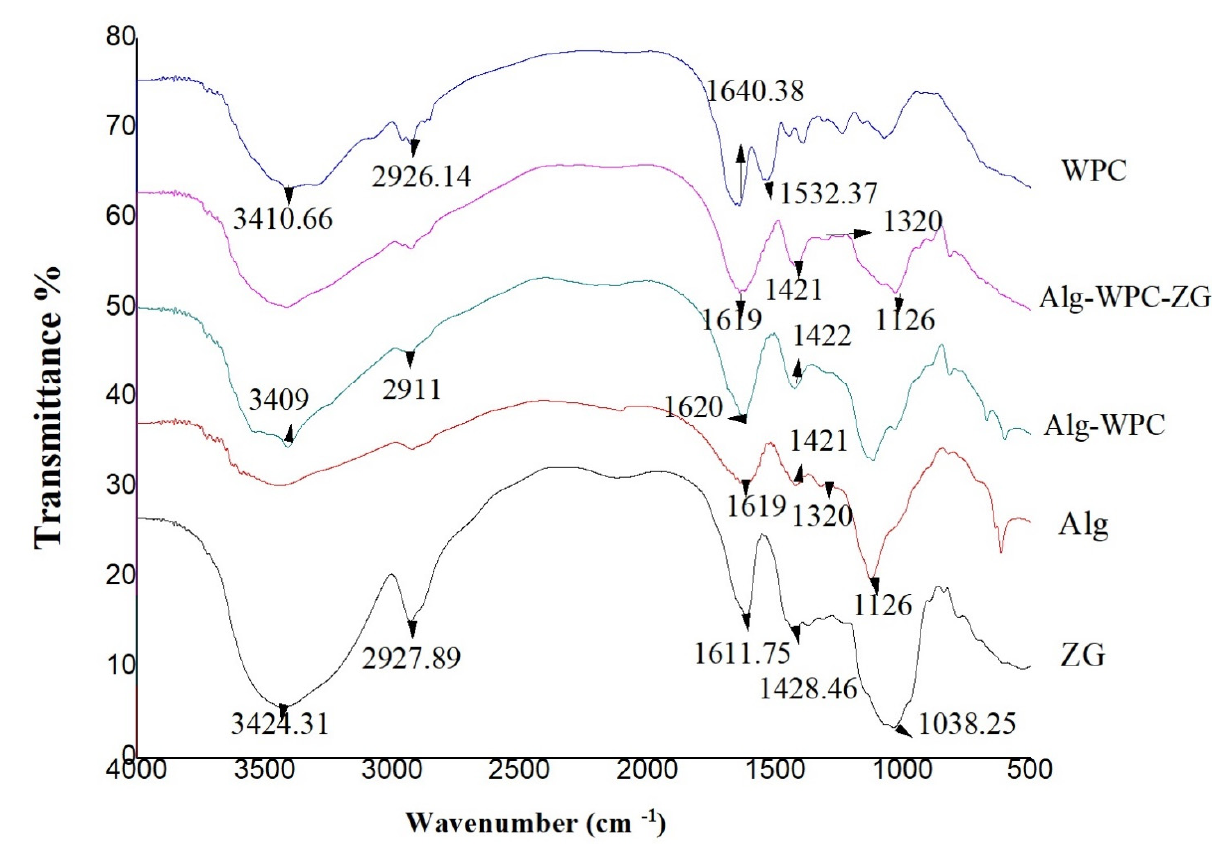
Figure 6. FTIR spectra of alginate (Alg), whey protein (WPC), zedo gum (ZG), alginate-whey protein microcapsules (Alg-WPC), and alginate-whey protein-zedo gum microcapsules